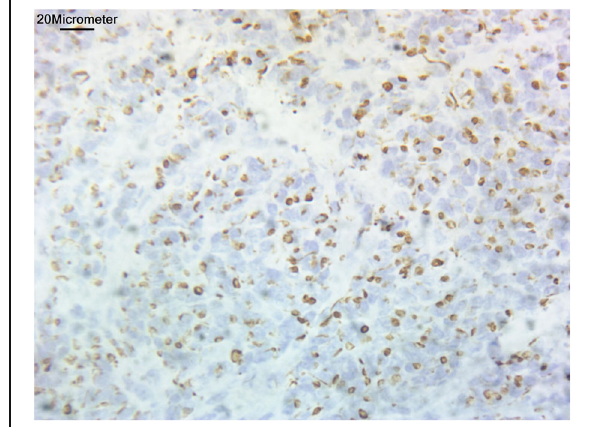
Fig. 3 Tumor tissue was negative for IHC